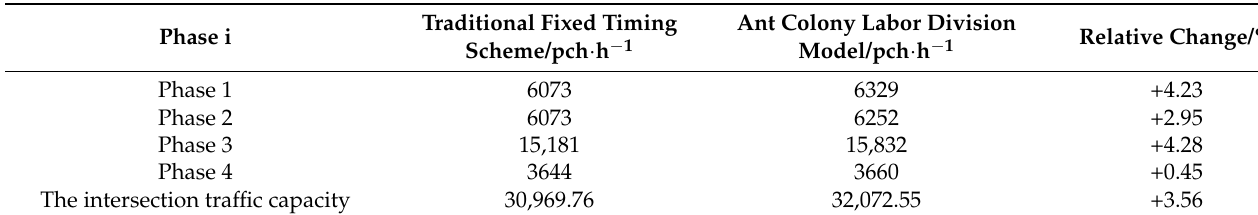
Table 3. Comparison of traffic capacity at intersections.